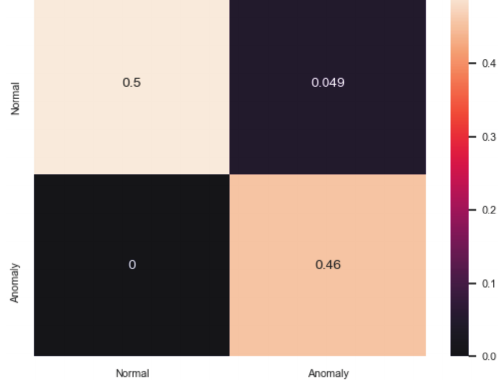
Figure 7. Confusion Matrix of ADM